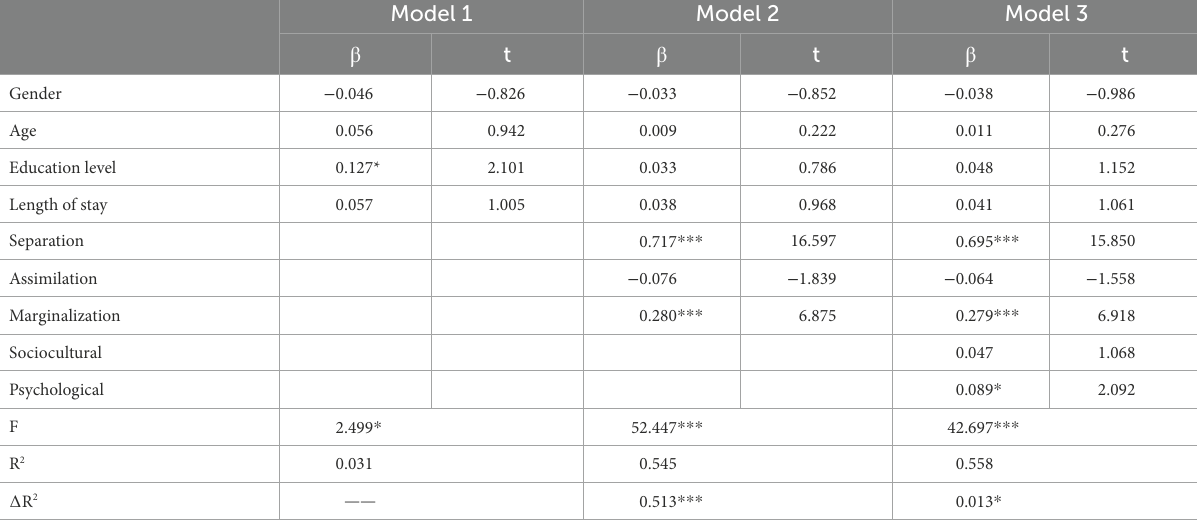
TABLE 6 Hierarchical regression analysis of the effects on academic